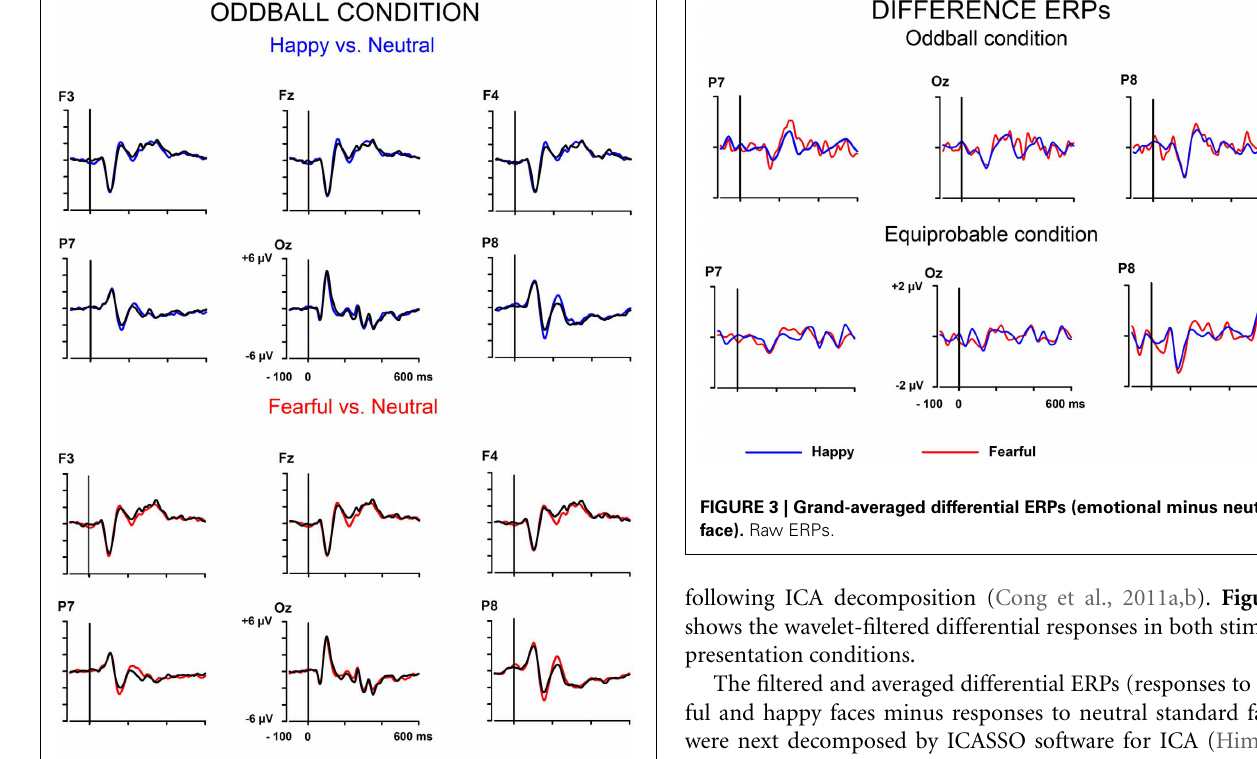
Ten levels were set to decompose the signal through the reversal biorthogonal wavelet with the order of 6.8, and coefficients at lev-